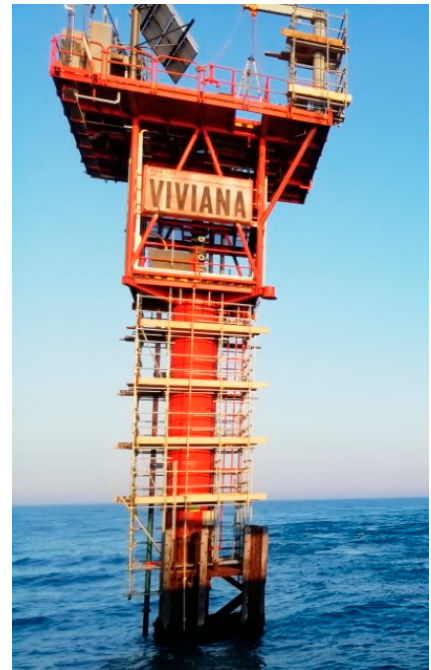
Figure 1. “ Viviana 1” platform. Figure 1. “Viviana 1”